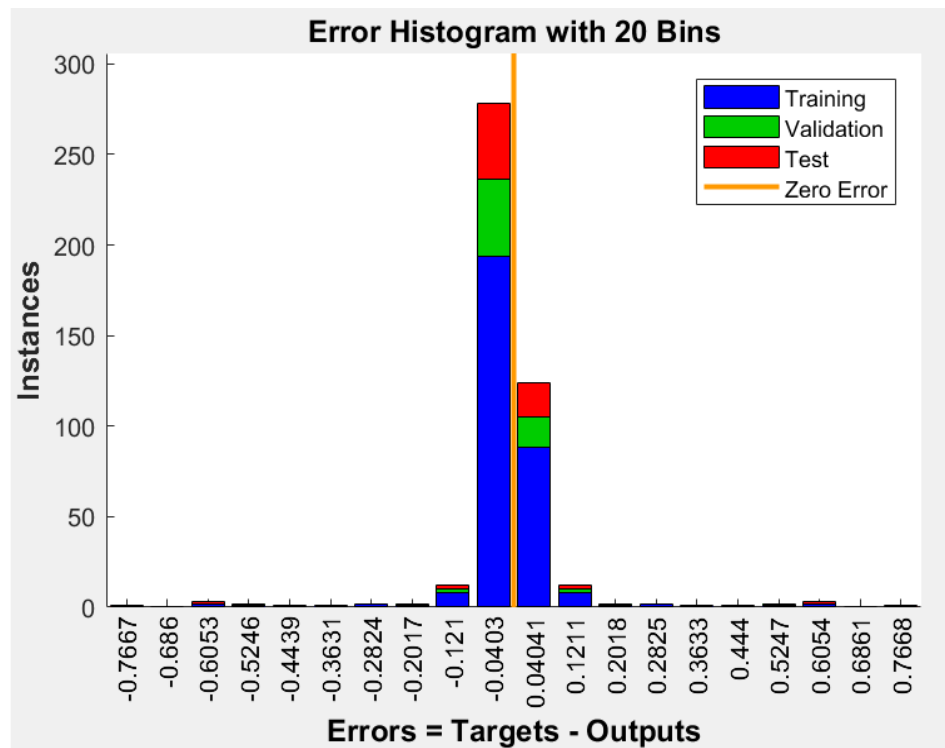
Figure 8. The achieved error histogram chart.